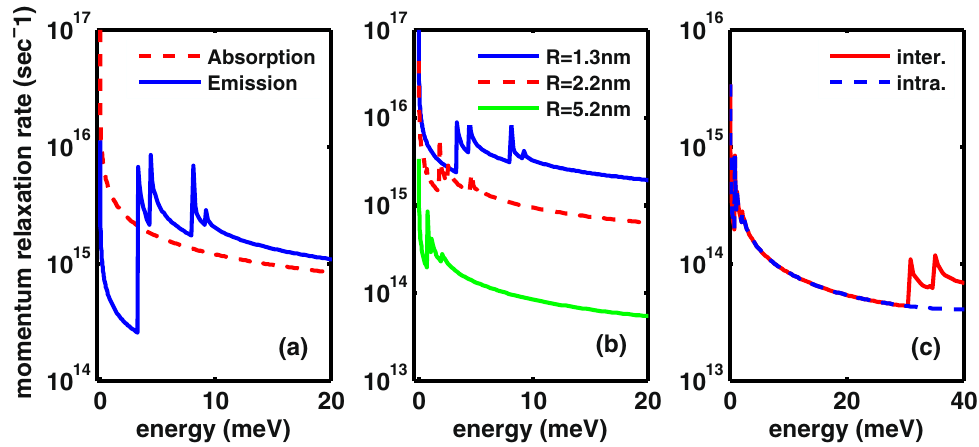
Figure 2. ( a ) Momentum relaxation rate (as a function of the initial energy of the electron) calculated for an InSb nanowire with radius 1.3 nm. The rates owing to phonon emission and absorption are presented separately and only phonon emission peaks appear in the rate. ( b ) The summed total relaxation rates for phonon emission and absorption, for a couple of cross sectional sizes. ( c ) Effect of inclusion of the intersubband scattering for an InSb nanowire with radius 5.2 nm (solid red curve). Compared to the intrasubband-only-scattering (blue dashed curve), magnitude change and additional peaks appear in the relaxation rate of electron with higher energies (e.g. over 30 meV in this plot). All the results in ( a – c ) are calculated under temperature 300